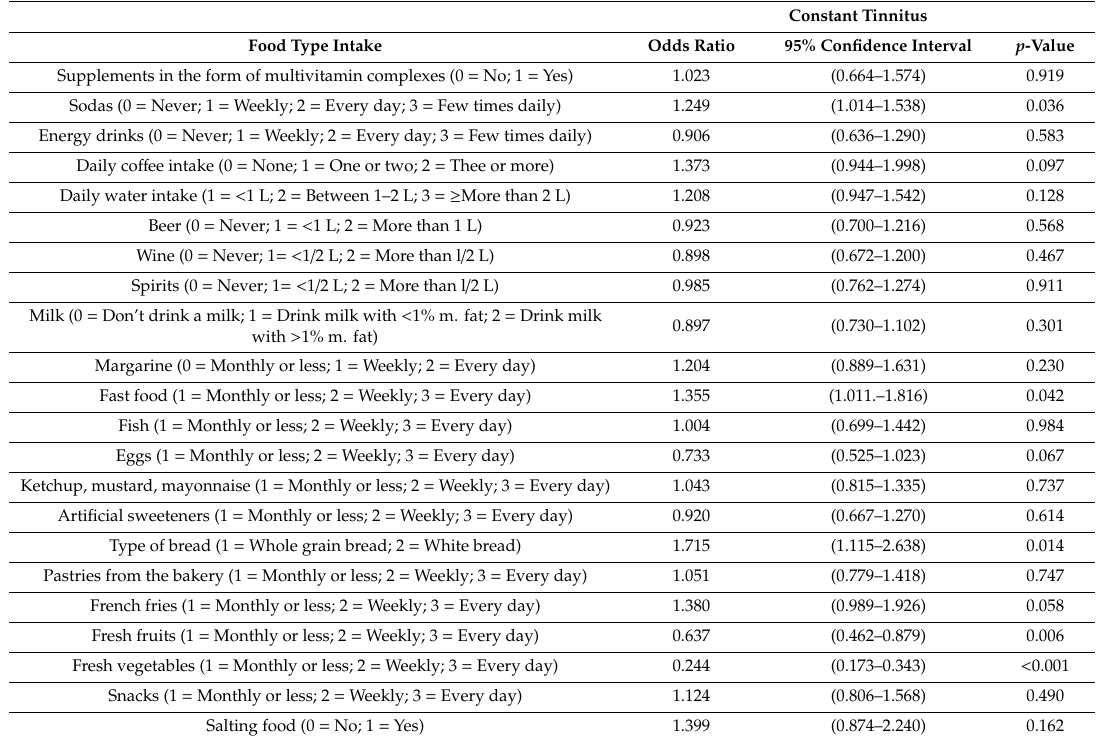
Table 3. The univariate logistic regression between dietary factors and constant tinnitus among adolescents ( n =